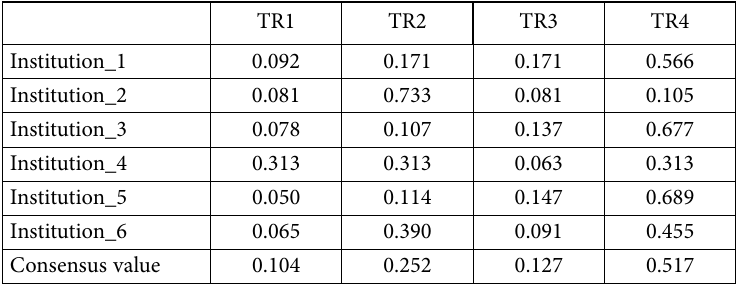
Table 2. Transparency-indicator weighting. General aspects (blocks of